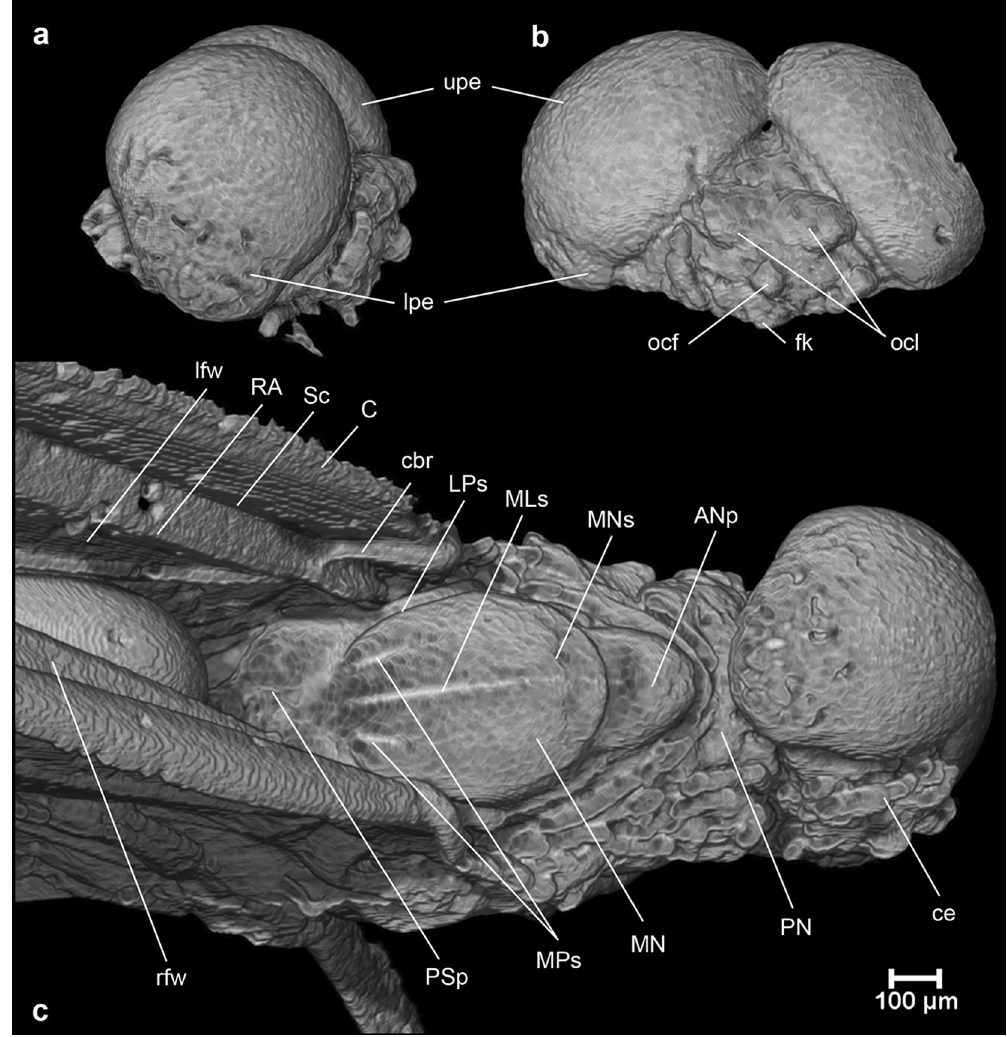
Figure 4. Micro-CT volume-rendered images of Calliarcys antiquus sp. nov. , holotype, male imago; Eocene Baltic amber; BB 2515 [SMNS coll.]; ( a ) head in right lateral view; ( b ) head in frontal view; ( c ) head and thorax in dorsal view. Abbreviations: ce—head; fk—facial keel; foc—frontal ocellus; loc—lateral ocelli; lp—lower portion of eye; up—upper portion of eye; C—costa; Sc—subcosta; RA—radius anterior; cbr—costal brace; lfw—left forewing; rfw—right forewing; ANp—anteronotal protuberance; LPs—lateroparapsidal suture; MN— mesonotum; MNs—mesonotal suture; MLs—median longitudinal suture; MPs—medioparapsidal suture; PN— pronotum; PSp—posterior scutal protuberance. Nomenclature of thoracic structures used throughout the text is based on 37